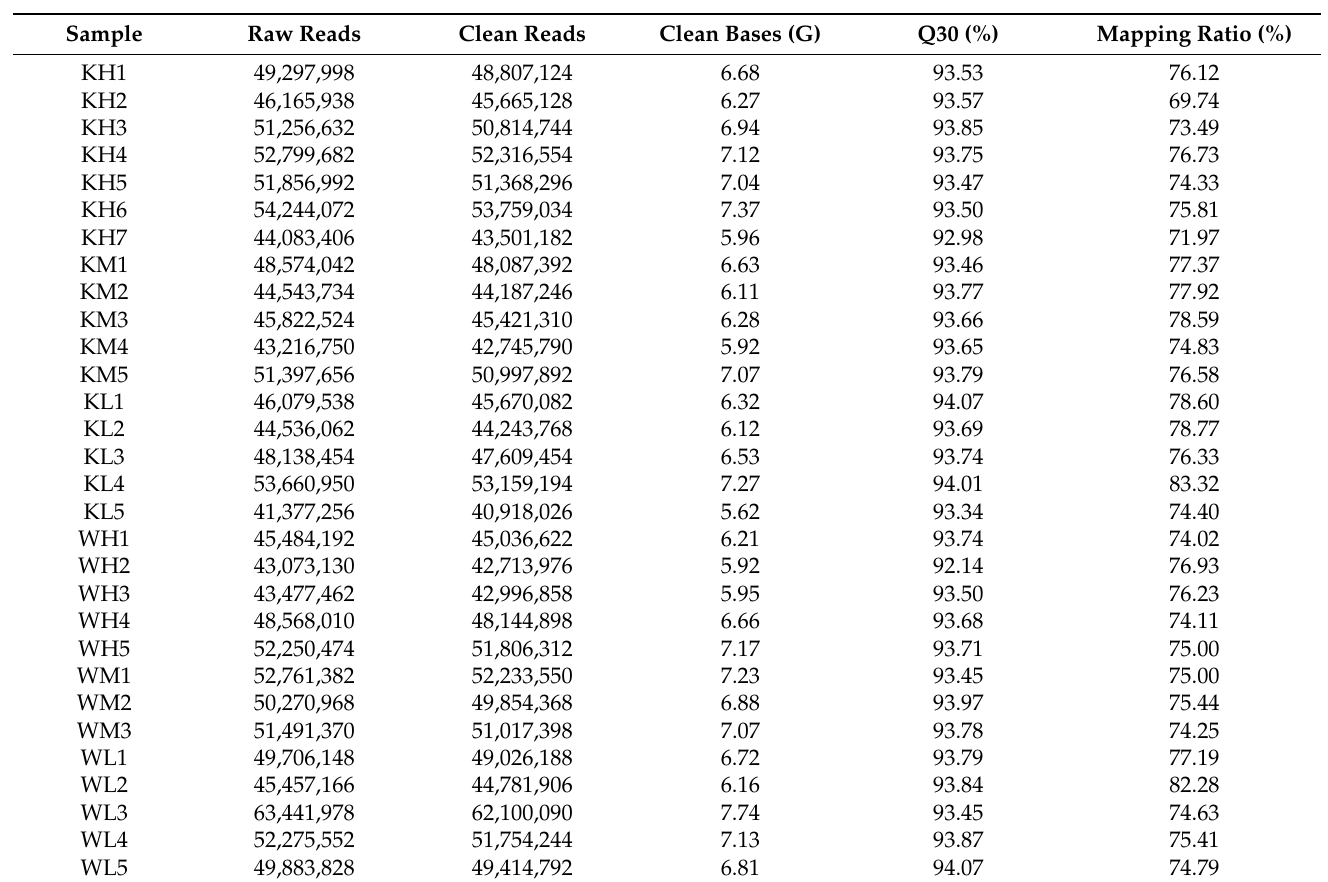
Table 1. Data quality and mapping ratios for all